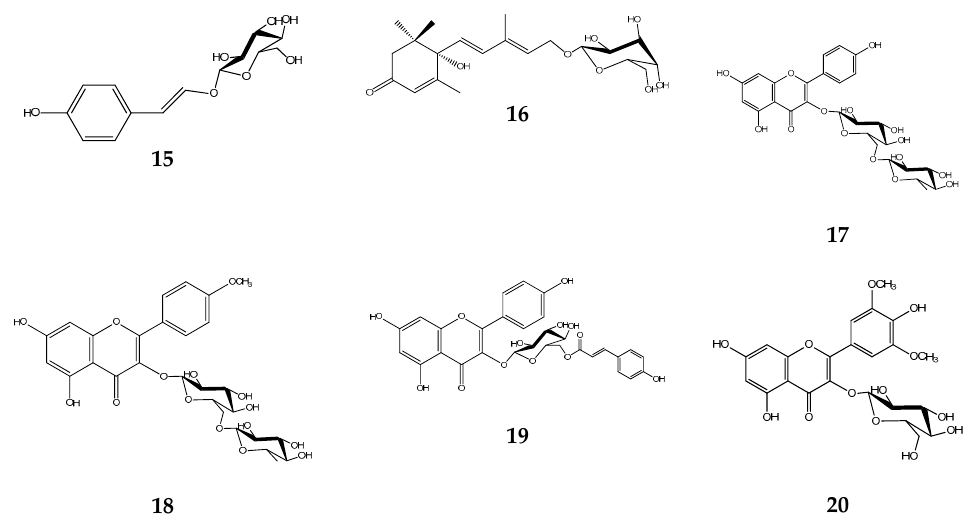
Figure 1. Structures of isolated compounds from C. brevifolia needles.